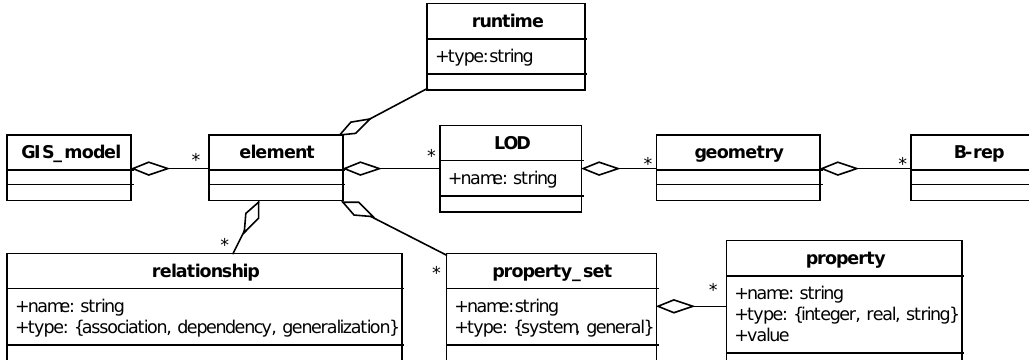
Figure 9. GIS DB conceptual model.